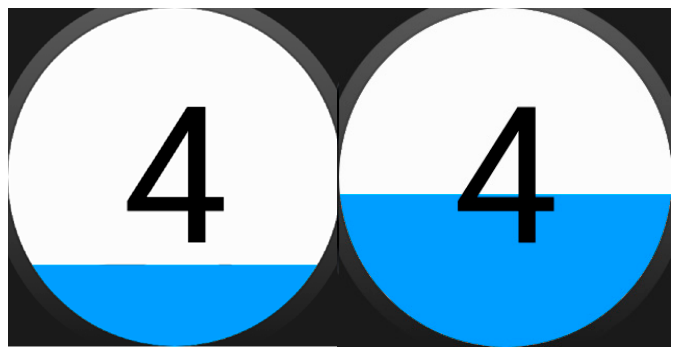
Figure 6. Counting strategy with screen ‐ filling timeout.